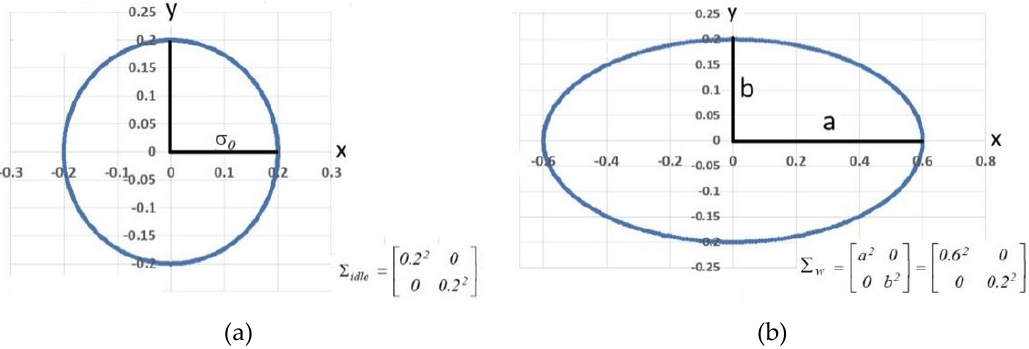
Figure 7. Wind direction model: ( a ) Idle state and ( b ) model considering wind velocity and